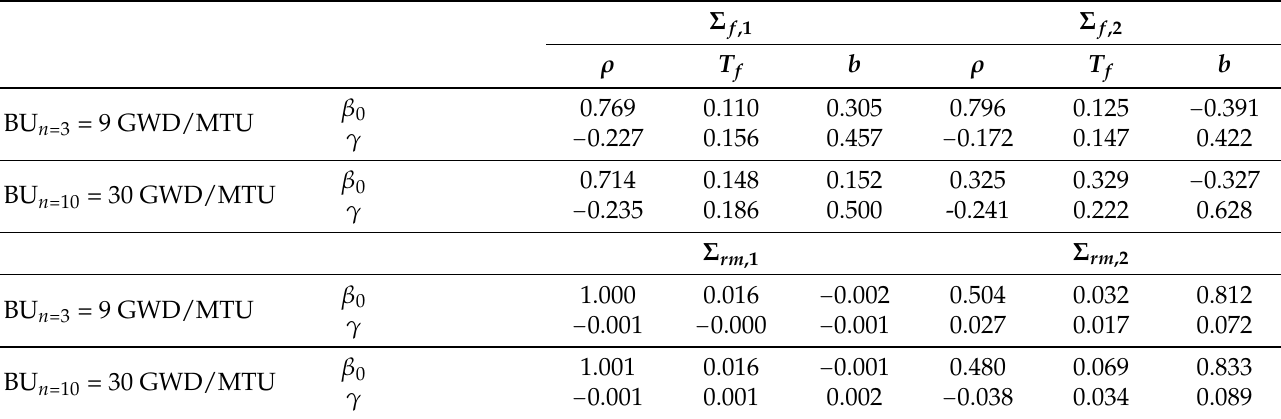
Table 3. SRC measures for the sensitivity of homogenized fission cross-section ( Σ f ) and homogenized removal cross-section ( Σ rm ) to instantaneous ( β 0 ) and burnup-averaged ( γ ) values for the coolant density ( ρ ), fuel temperature ( T f ), and boron concentration in coolant ( b ). Results are calculated using the RHM with Q = 0. Numerical digit subscripts on cross-sections indicate neutron energy